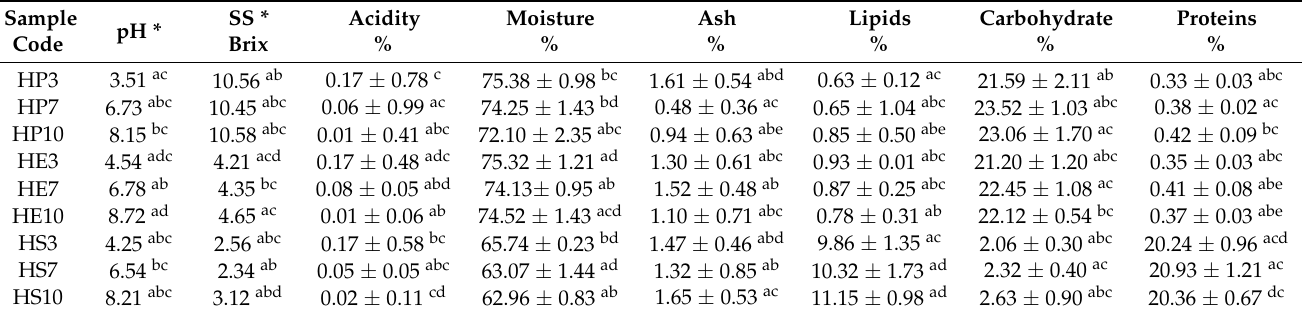
Table 1. Proximalcompositionandphysicochemicalpropertiesofthehydrocolloidsofmango( Mangiferain- dica ) var. hilaza. at different